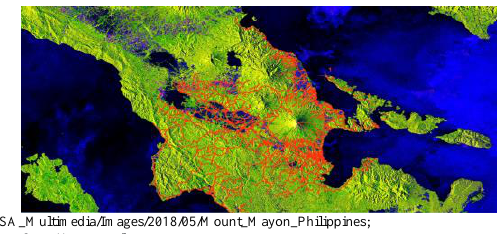
Figure 3 . OSM roads trends and connectivity